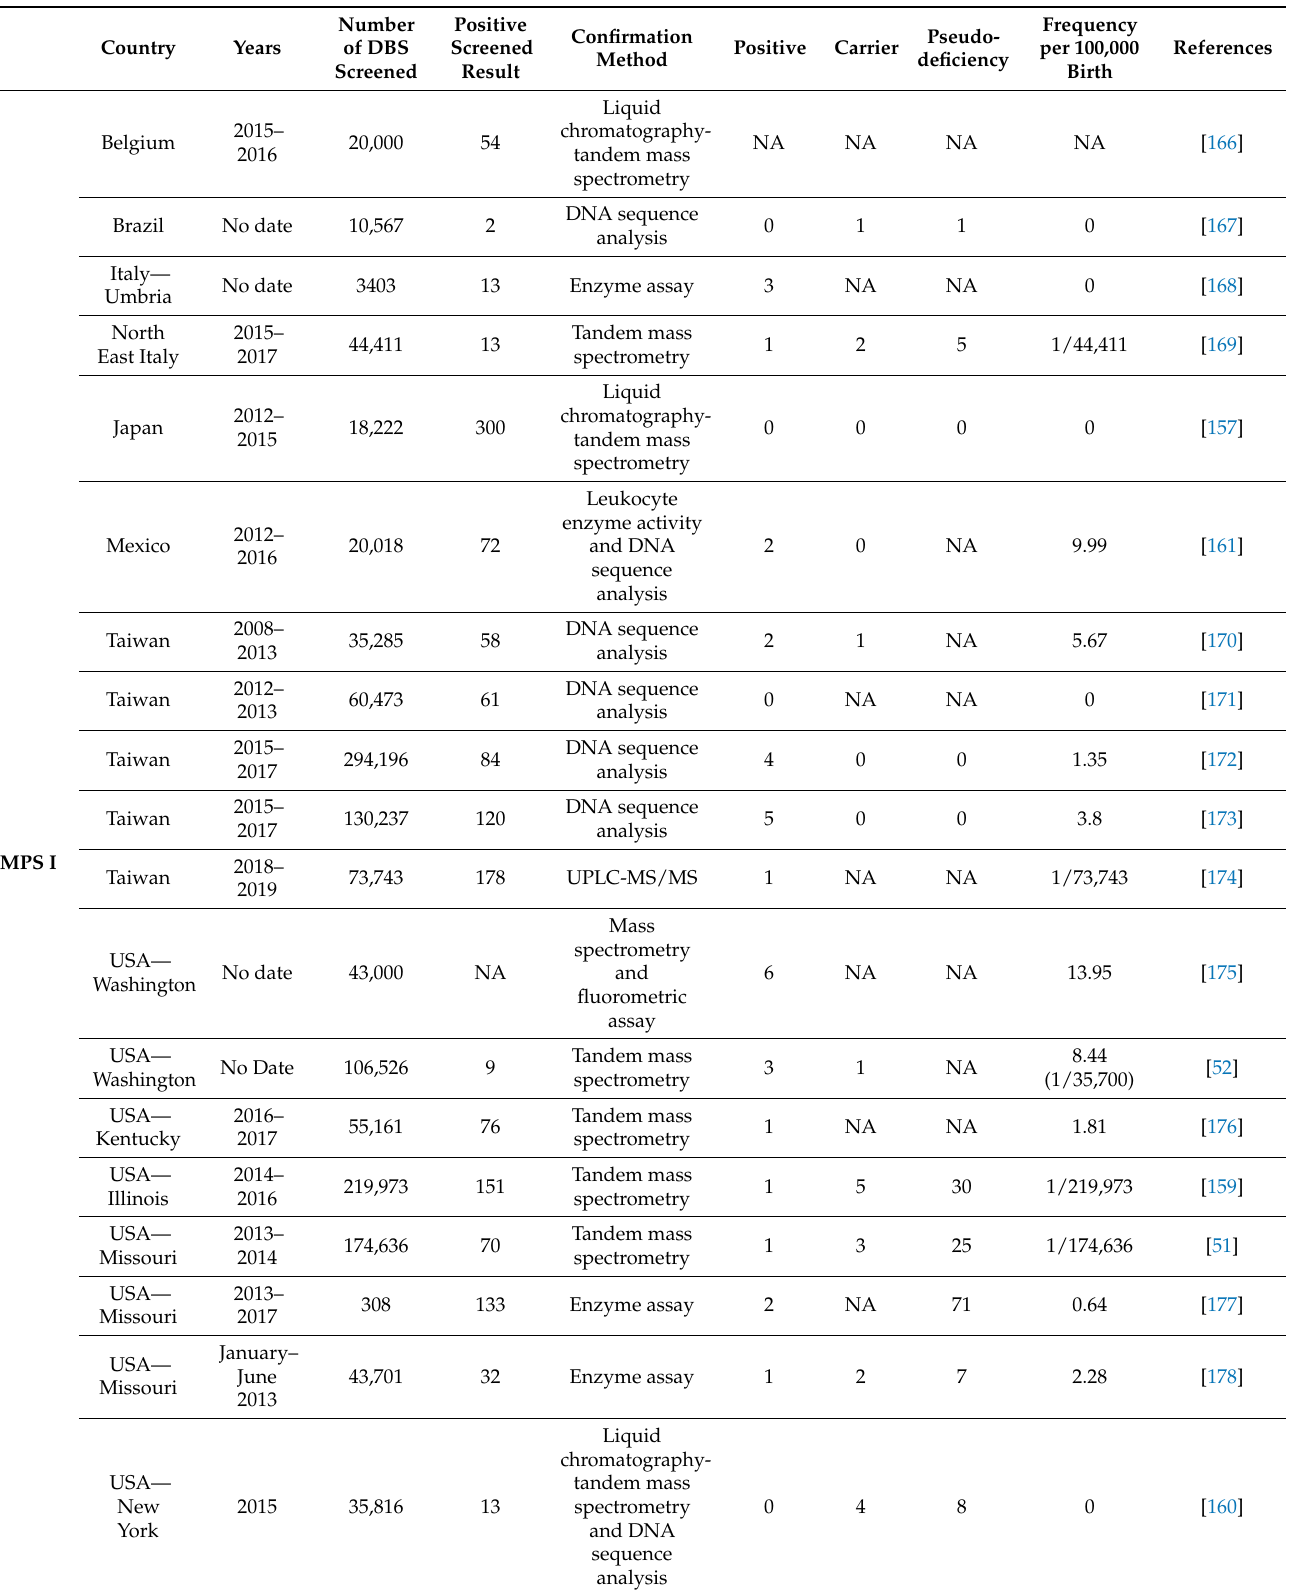
Table 4. Newborn screening results in seven countries for MPS